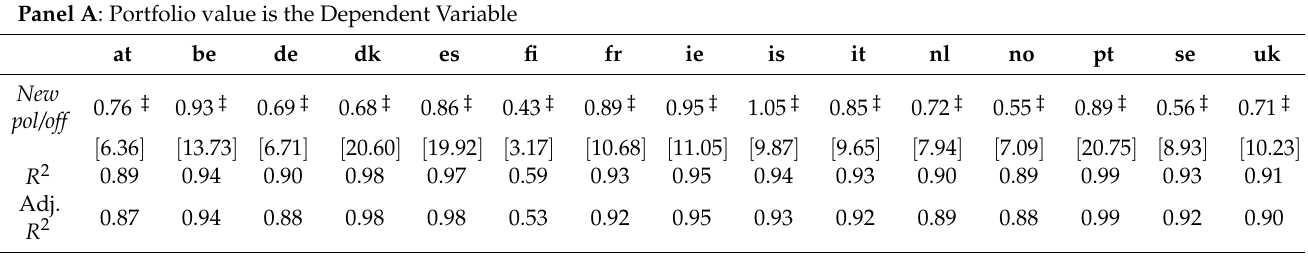
Table 3. Explaining Portfolio value, Institutional Change, and Platform